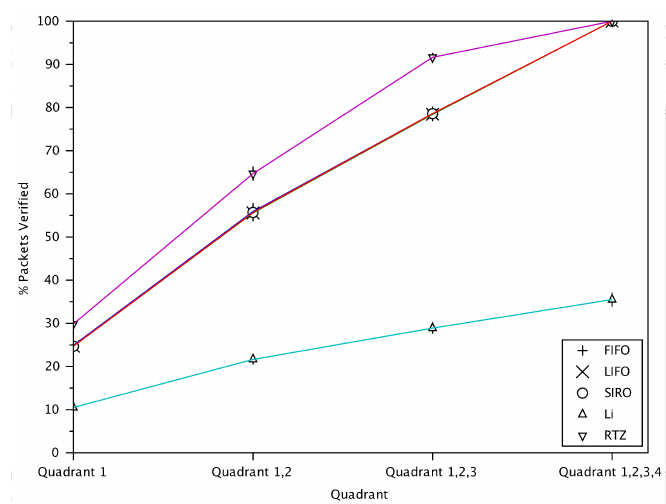
Figure 8. The cumulative percentage of verified messages from different quadrants.